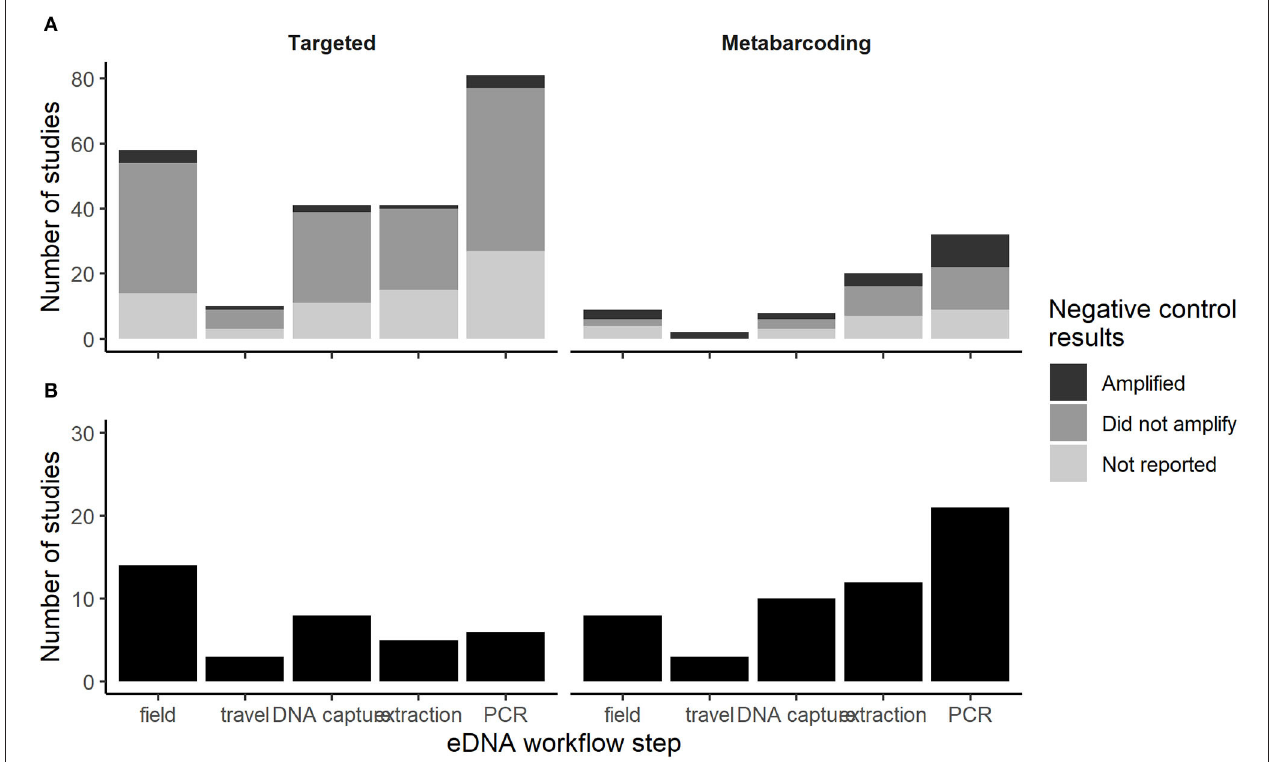
FIGURE 4 | The number of studies in the first (A) and second (B) literature reviews with eDNA workflow steps associated with negative controls that amplified, did not amplify, or amplification results were not